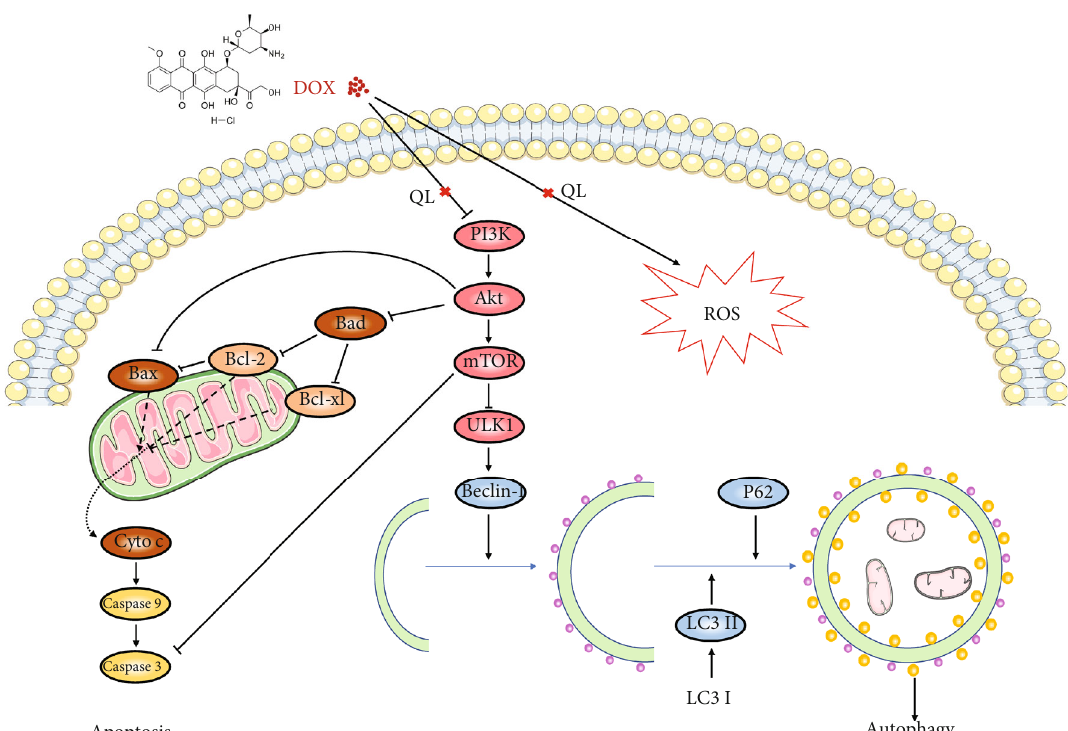
Figure 8: The schematic illustration of the potential molecular mechanisms by which QL alleviated DOX-induced